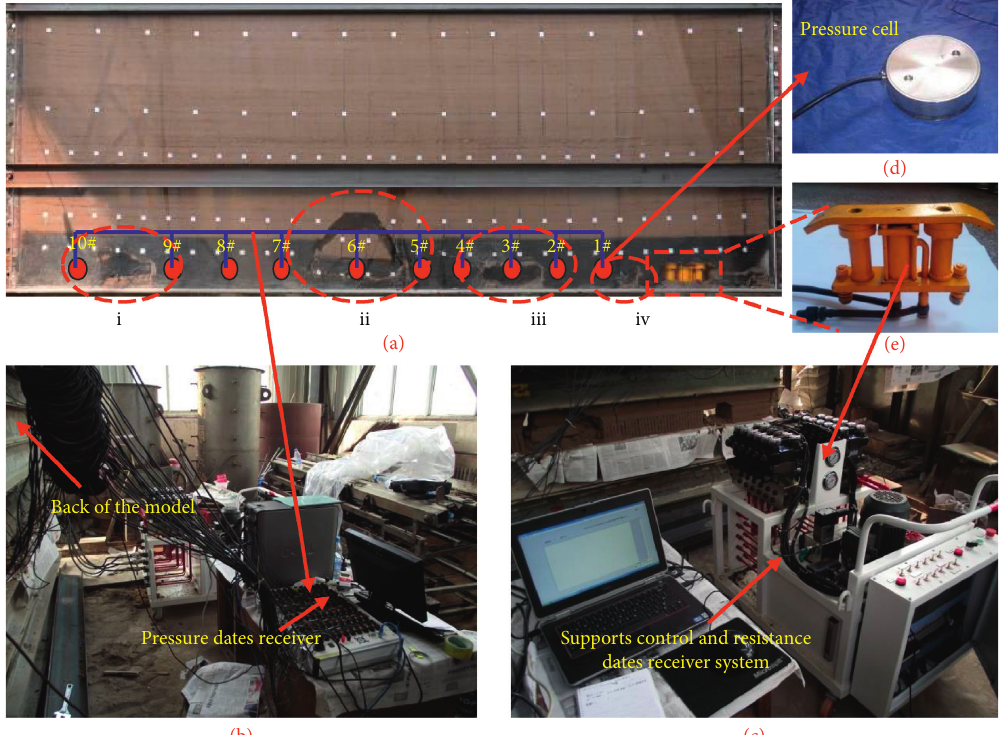
Figure 4: The in situ investigation photos and schematic diagram of a serious accident. (a) Two-dimensional model; (b) pressure dates receiver; (c) supports control and resistance dates receiver system; (d) pressure cells; (e) physical simulation